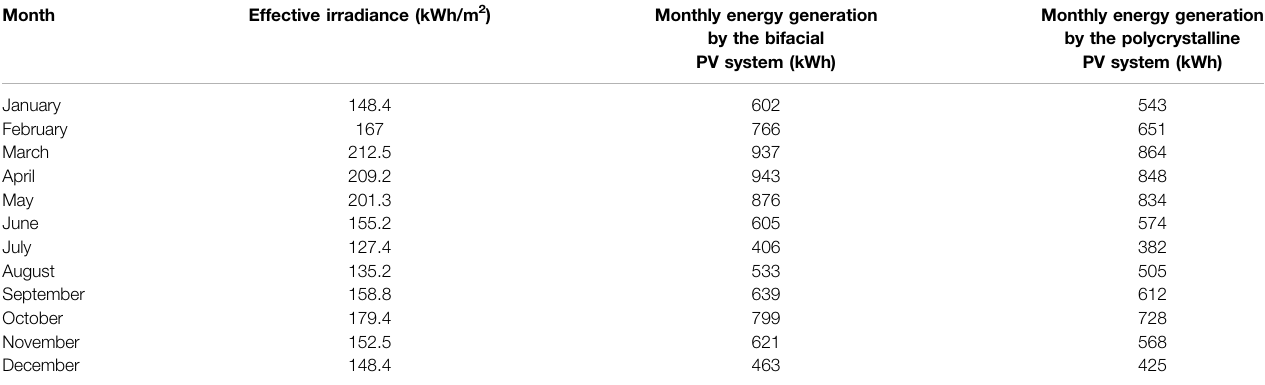
TABLE 2 | Monthly energy generation.